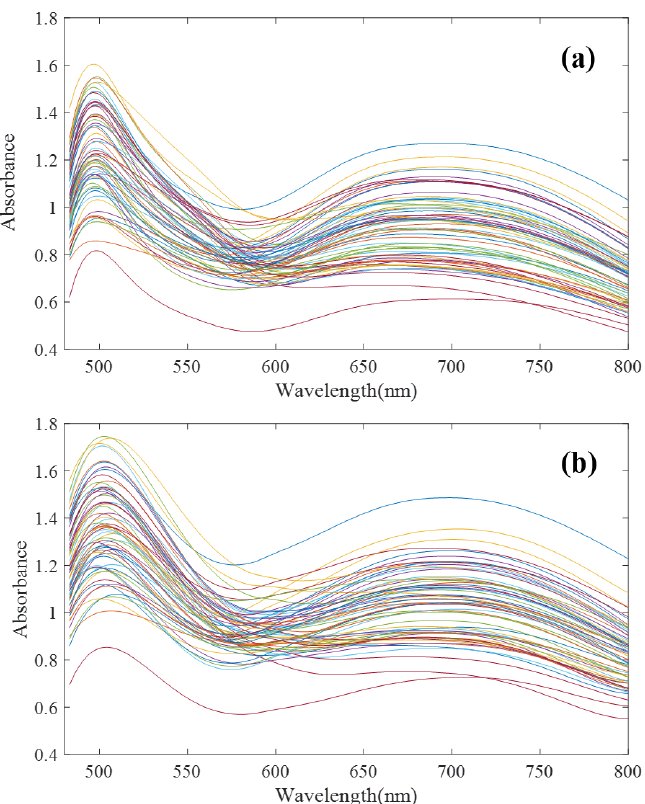
Figure 4. Ultraviolet Visible (UV-Vis) spectra of 64 groups of Cu, Co and Fe mixed solutions. ( a ) T9 spectrometer; ( b ) ATP2000 spectrometer (after